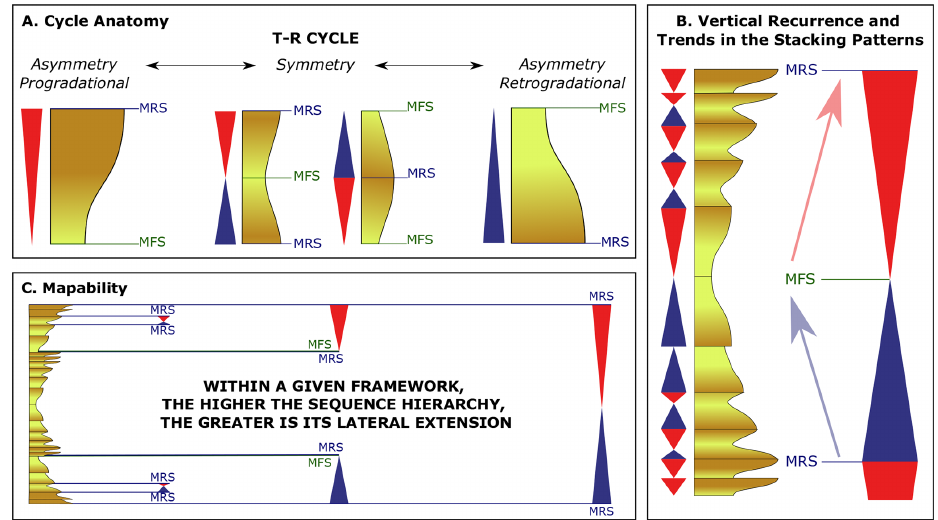
Figure 26. Characteristics and criteria for defining stratigraphic sequences within a cyclic and hierarchical framework (modified from Fragoso et al., 2021): (a) T – R cycle anatomy. (b) Vertical recurrence of individual cycles and trends in the cyclic stacking pattern (modulation of the smallest by the highest hierarchy). (c) Mappability of the stacking patterns and stratigraphic surfaces within a given framework, which is more significant the higher the hierarchy is. Abbreviations: MFS – maximum flooding surface; MRS – maximum regressive surface.